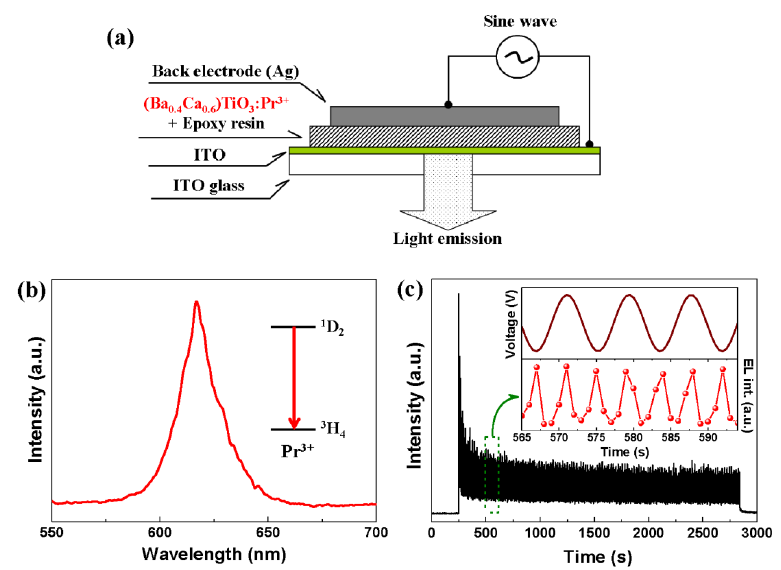
Figure 2. ( a ) Schematic structure of AC electroluminescent device based on (Ba 0.4 Ca 0.6 )TiO 3 :Pr 3+ ; ( b ) electroluminescent spectra of (Ba 0.4 Ca 0.6 )TiO 3 :Pr 3+ -based device, showing the characteristic emission of Pr 3+ of 1 D 2 - 3 H 4 transition; ( c ) electroluminescent behavior of (Ba 0.4 Ca 0.6 )TiO 3 :Pr 3+ -based